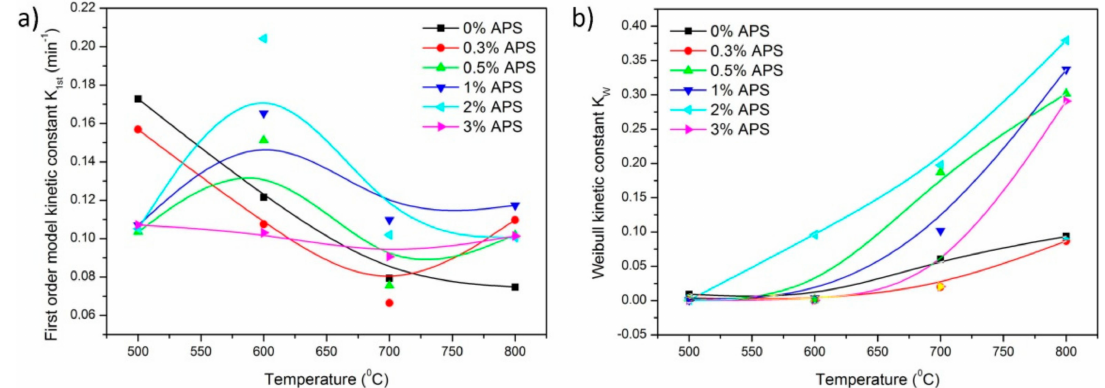
Figure 7. Kinetic constants obtained from the fittings of the release profiles to di ff erent kinetic models ( a ) First order kinetic model and ( b ) Weibull kinetic model. In the x-axis it is shown the temperature at which the particles were obtained.